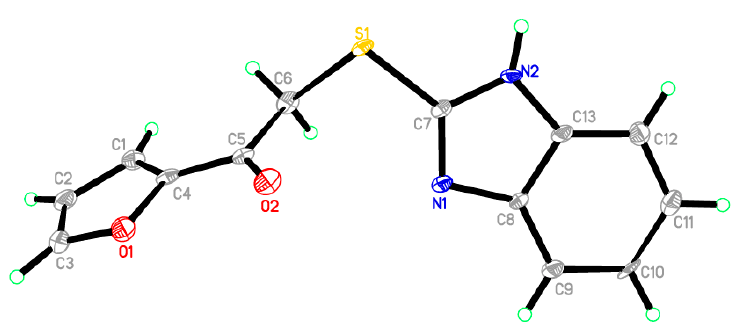
Figure 4. An ORTEP diagram of the final X-ray structure of compound 5v . Table 1. Crystallographic data and refinements for compounds 4u and 5v .